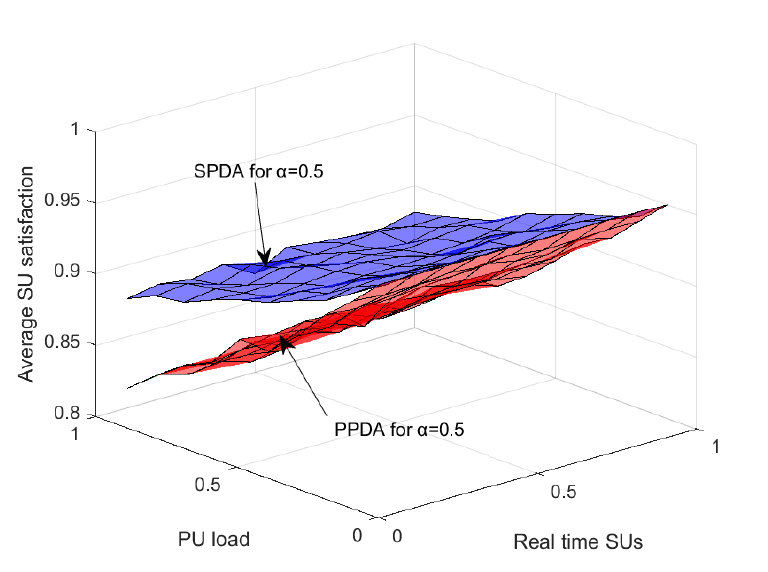
Figure 12. SPDA and PPDA average SU satisfaction with variation in PU load and real time